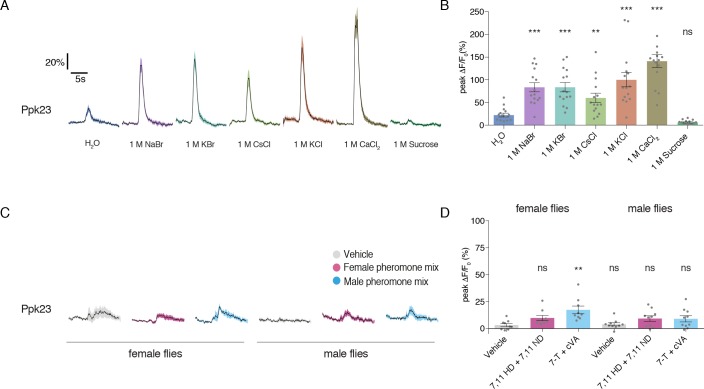
Ppk23 neurons respond strongly to all salts and only weakly to pheromones.(A) Time curves of GCaMP6f activation in Ppk23 GRNs following stimulation with 1 M solutions of various salts and sucrose. Lines and shaded regions indicate mean ±SEM. (B) Peak changes during stimulation with each tastant. Bars represent mean ±SEM, n = 15. Asterisks indicate significant difference from water by one-way ANOVA with Bonferroni post hoc test, *p<0.05, **p<0.01, ***p<0.001. (C) Time curves of GCaMP6f activation in Ppk23 GRNs following stimulation with male or female pheromone mixtures. Lines and shaded regions indicate mean ±SEM. Female pheromone mixture is 7,11 HD plus 7,11 ND; male mixture is 7 T and cVA. (D) Peak changes during stimulation with each pheromone mix. Bars represent mean ±SEM, n = 9–10. Asterisks indicate significant difference from vehicle stimulations by one-way ANOVA with Bonferroni post hoc test, *p<0.05, **p<0.01, ***p<0.001.